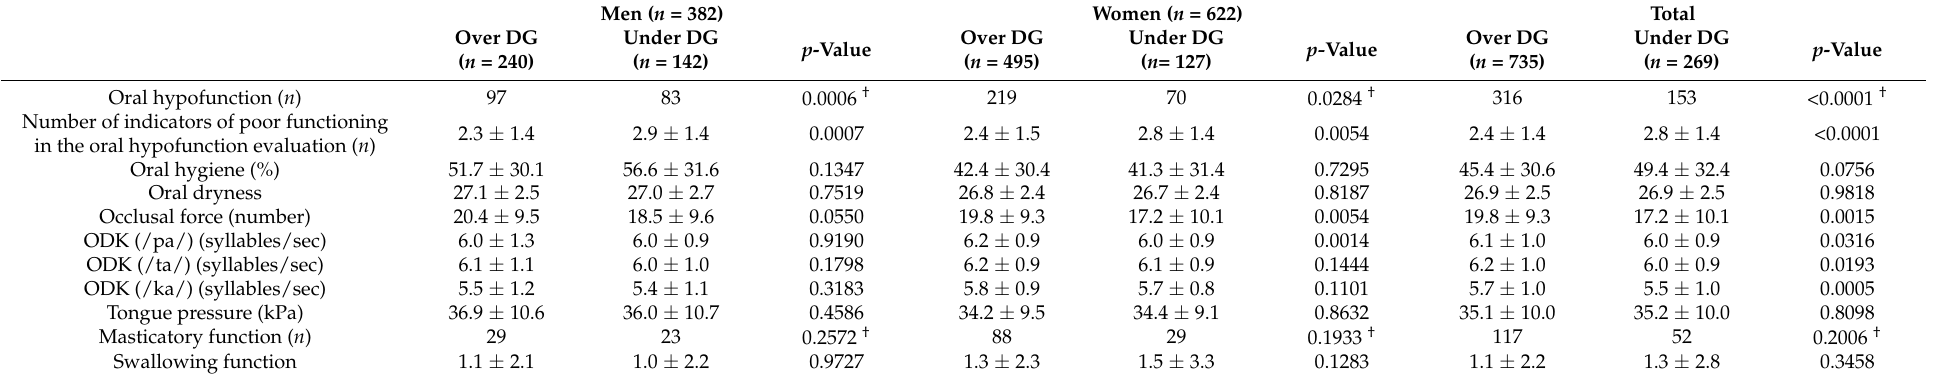
Table 5. Results of examination for oral hypofunction in groups according to over-DG and under-DG protein